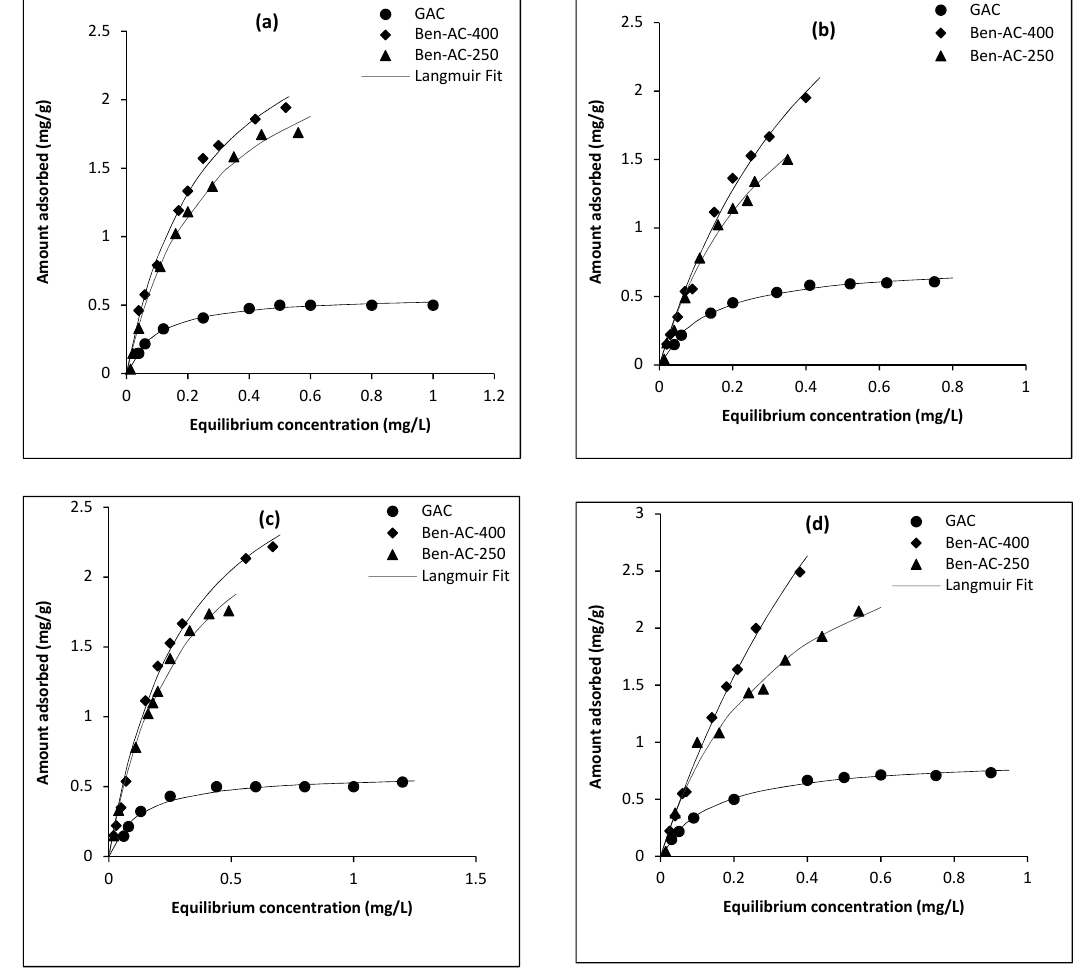
Figure 4. Langmuir adsorption isotherms of micropollutants ( a ) CBZ; ( b ) OP; ( c ) NP; ( d ) NP on granular activated carbon (GAC), Ben-AC-400 and Ben-AC-250.